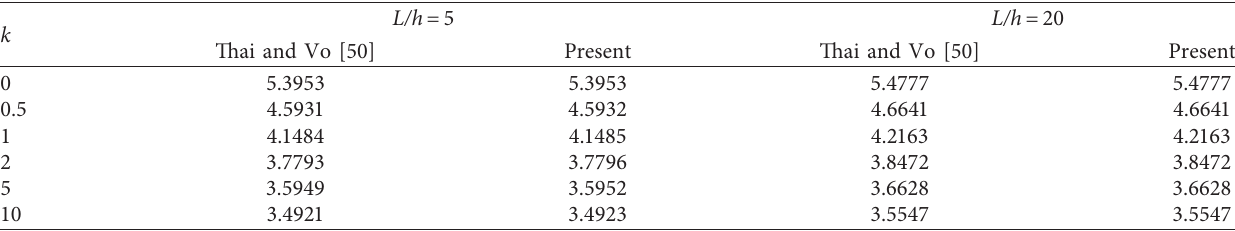
Table 3: The first nondimensional natural frequencies of FG